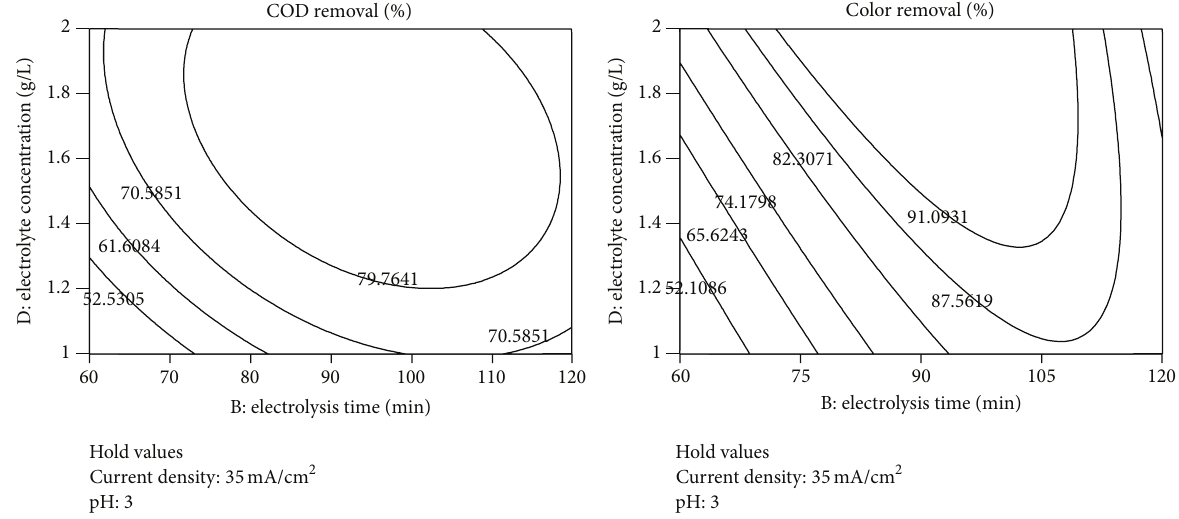
Figure 8: Contour plots between electrolysis time and electrolyte concentration for the